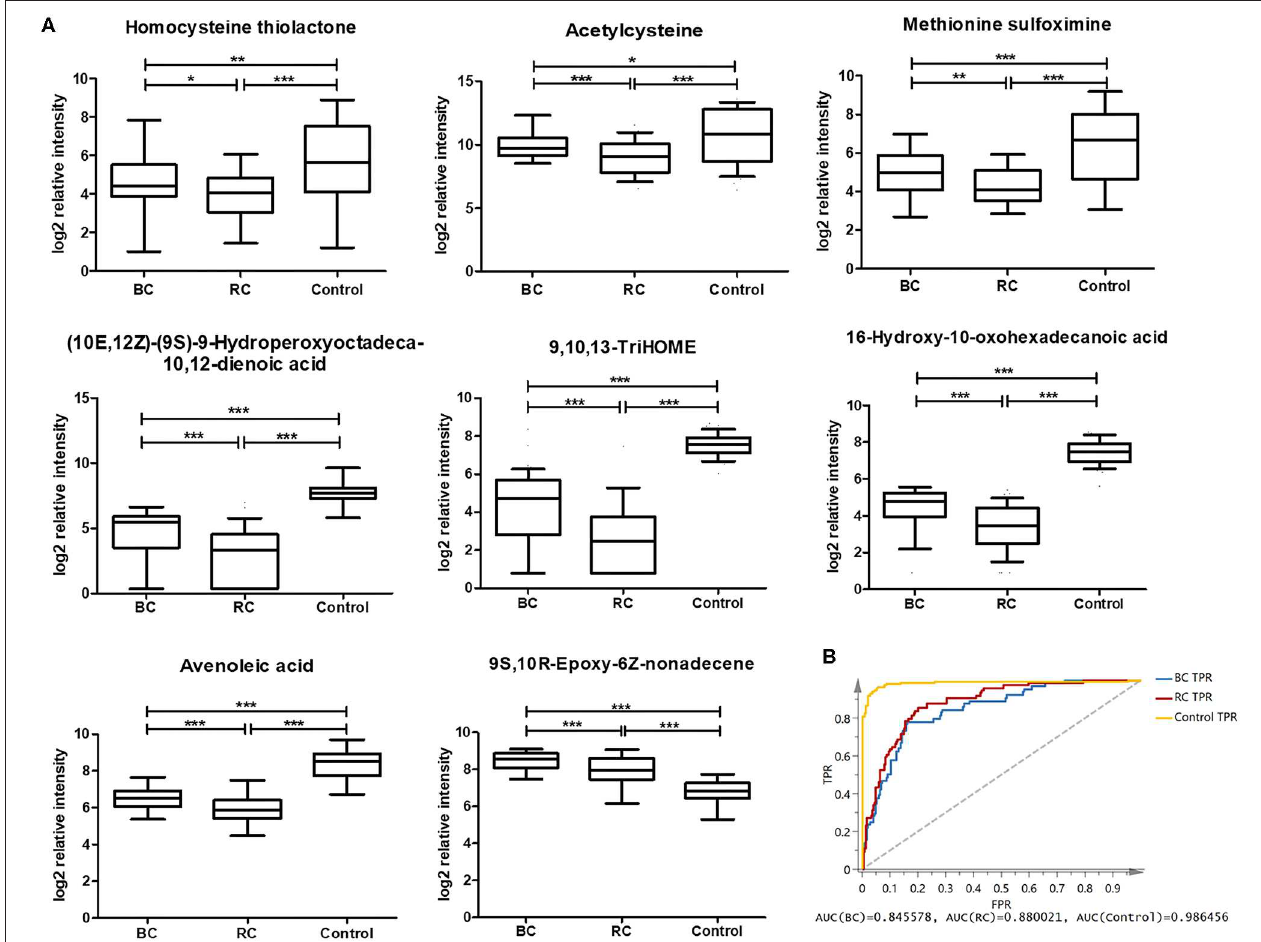
FIGURE 4 | Analysis of 8 common differential metabolites in BC (64 samples), RCC (74 samples), and control (141 samples) group. Homocysteine thiolactone and acetylcysteine were confirmed by standard compounds. (A) Relative intensity of 8 common differential metabolites in BC, RCC, and control group. *, **, and *** represent p -value less than 0.05, 0.01, and 0.001 between two groups, respectively. (B) Score plot based on 8 common differential metabolites for BC, RCC, and control